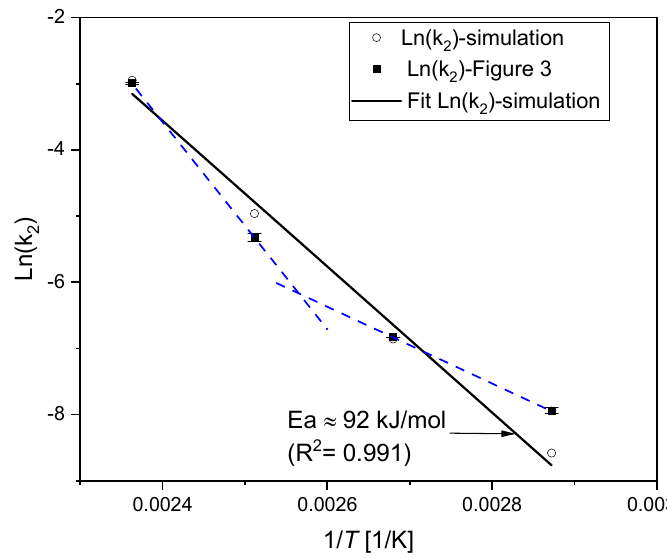
Figure 11. The correlation of the second-order kinetic rate constants to the Arrhenius relationship: Comparison of the simulated rates with the values of Figure 3.